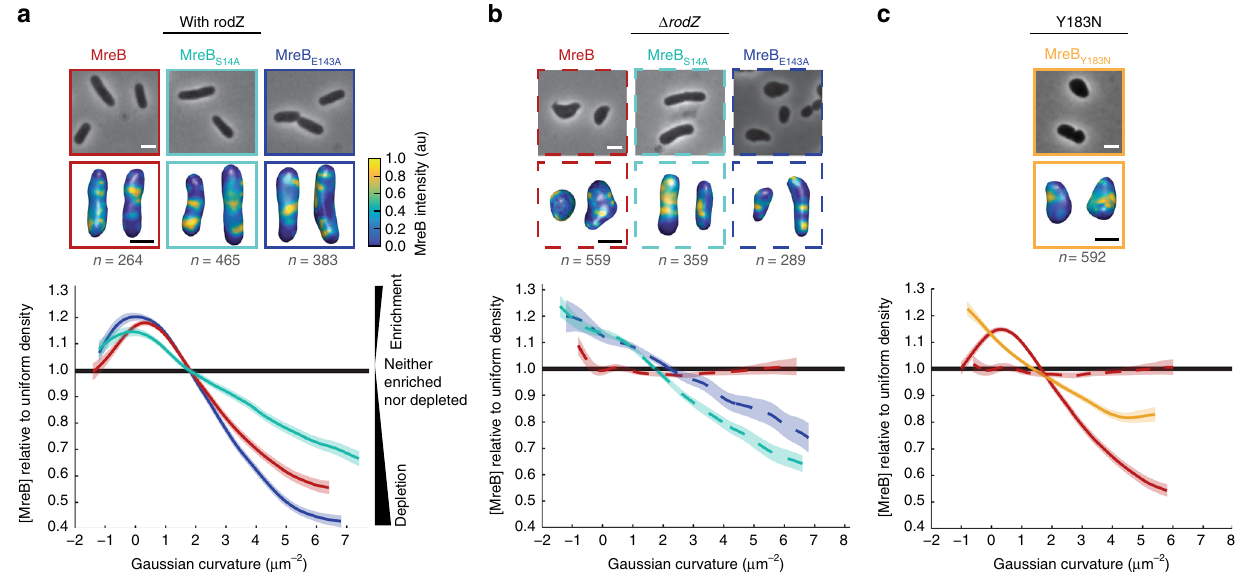
Fig. 2 MreB curvature localization is necessary but not suf fi cient for rod shape determination. a MreB enrichment curves of MreB point mutants with RodZ present. b MreB enrichment curves of MreB point mutants in a rodZ deletion. c MreB enrichment curve of MreB Y183N . Top images are 2D cells and bottom images are 3D cells with MreB shown according to the color intensity scale in a . The number of independent cells that contributed to the enrichment plots is indicated in gray. Shaded areas of the curves indicate ± 1 standard error of the mean and dotted lines indicate strains deleted of rodZ . The curve for each strain is a cubic smoothing spline and is truncated using a probability threshold for extreme curvatures of p > 5 × 10 − 3 (Supplementary Fig. 5). Because the shape of each strain is different, the ranges of curvatures plotted for each strain are different. These experiments were performed on three separate days and the data were pooled. White scale bar for all phase images is 2 μ m and the black scale bar for all 3D reconstructions is 1 μ